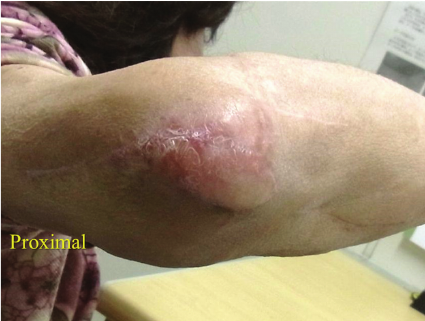
Figure 4: Three years after